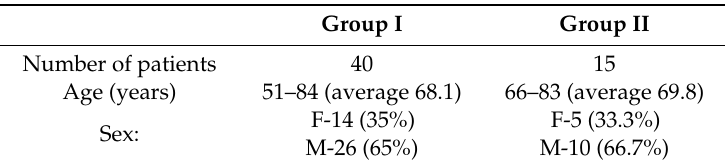
Table 1. Demographic and epidemiological